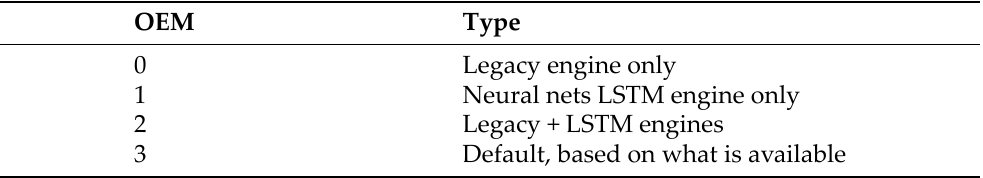
Table 8. Tesseract OCR engine